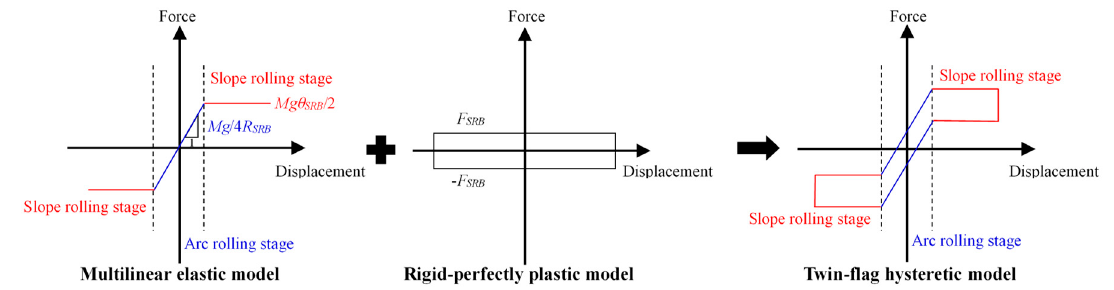
Figure 3. Idealized composition of analytical models for SRBs.